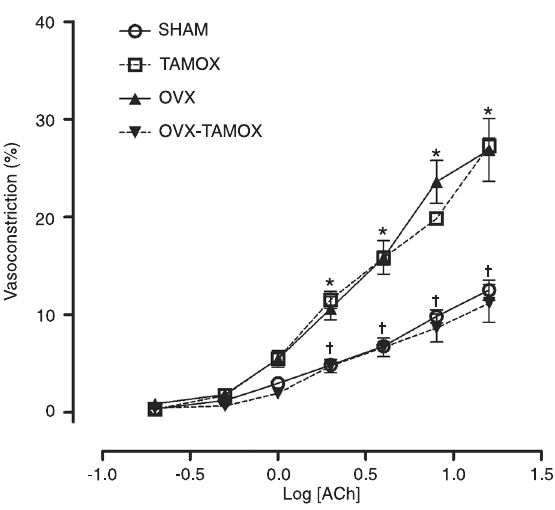
Figure 2. Coronary perfusion pressure values reported as a percentage of coronary vascular bed contraction with increasing doses of acetylcholine (Ach) in the four treatment groups (SHAM, TAMOX, OVX, and OVX+TAMOX; for abbreviations, see legend to Table 1). Data are reported as means ± SEM (N = 7 rats in each group). *P < 0.01 compared to the SHAM group; † P < 0.01 compared to the OVX group (ANOVA followed by the Tukey post hoc test).